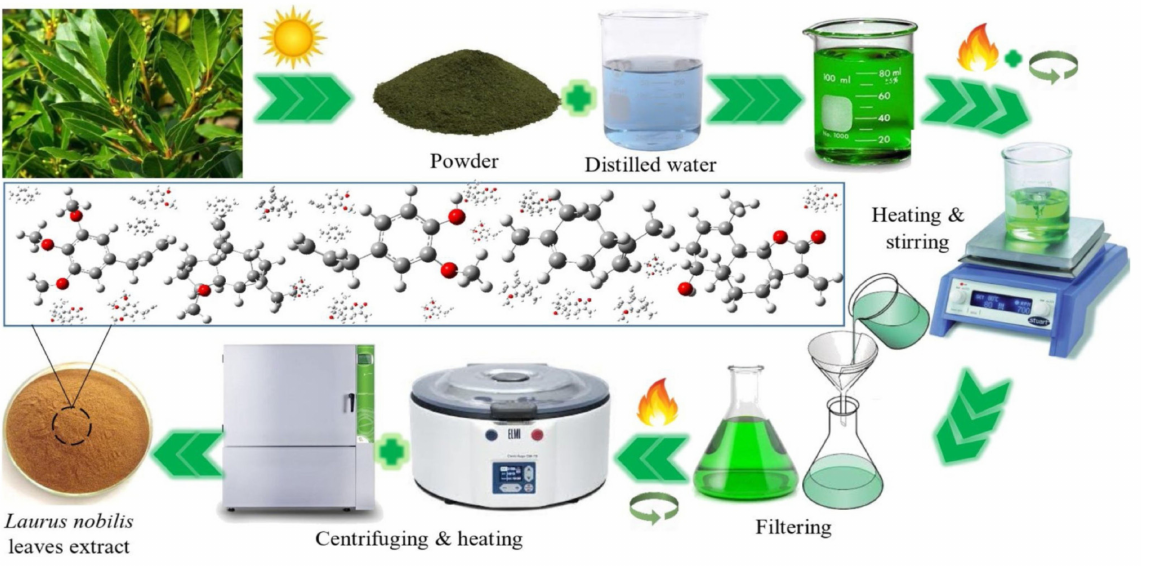
Figure 10. Schematic route for preparing Laurus nobilis leaf extract powder that was used for mild steel corrosion prevention. (Reprinted with permission from Ref. [213]. Copyright 2020 Elsevier Publications).